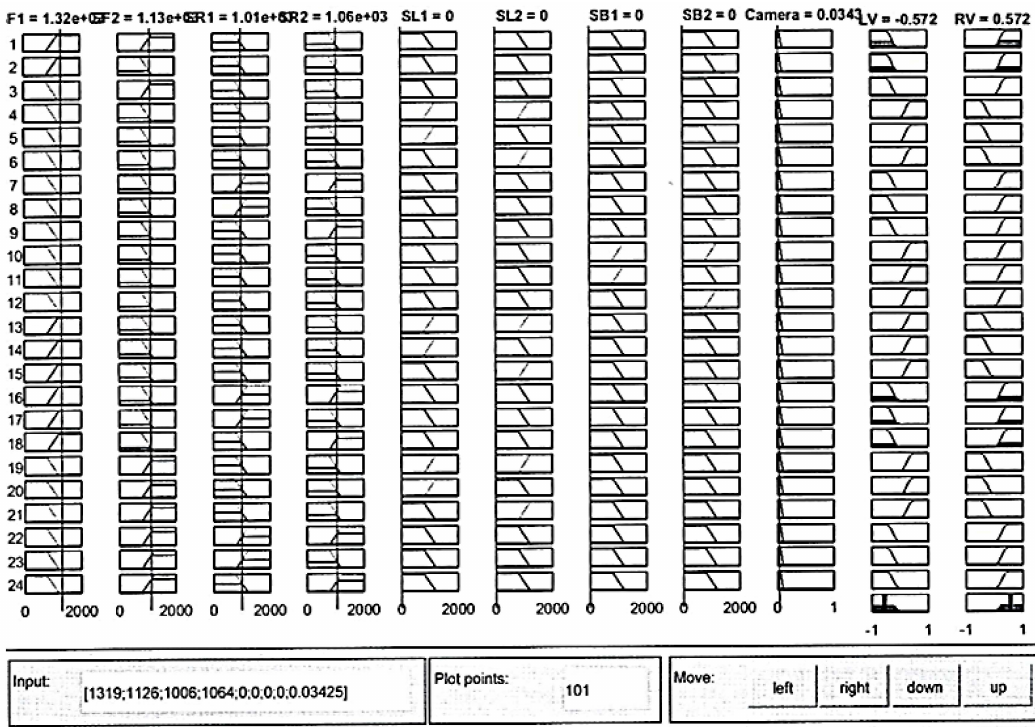
Figure 25. An example of the fusion model at MATLAB’s rules